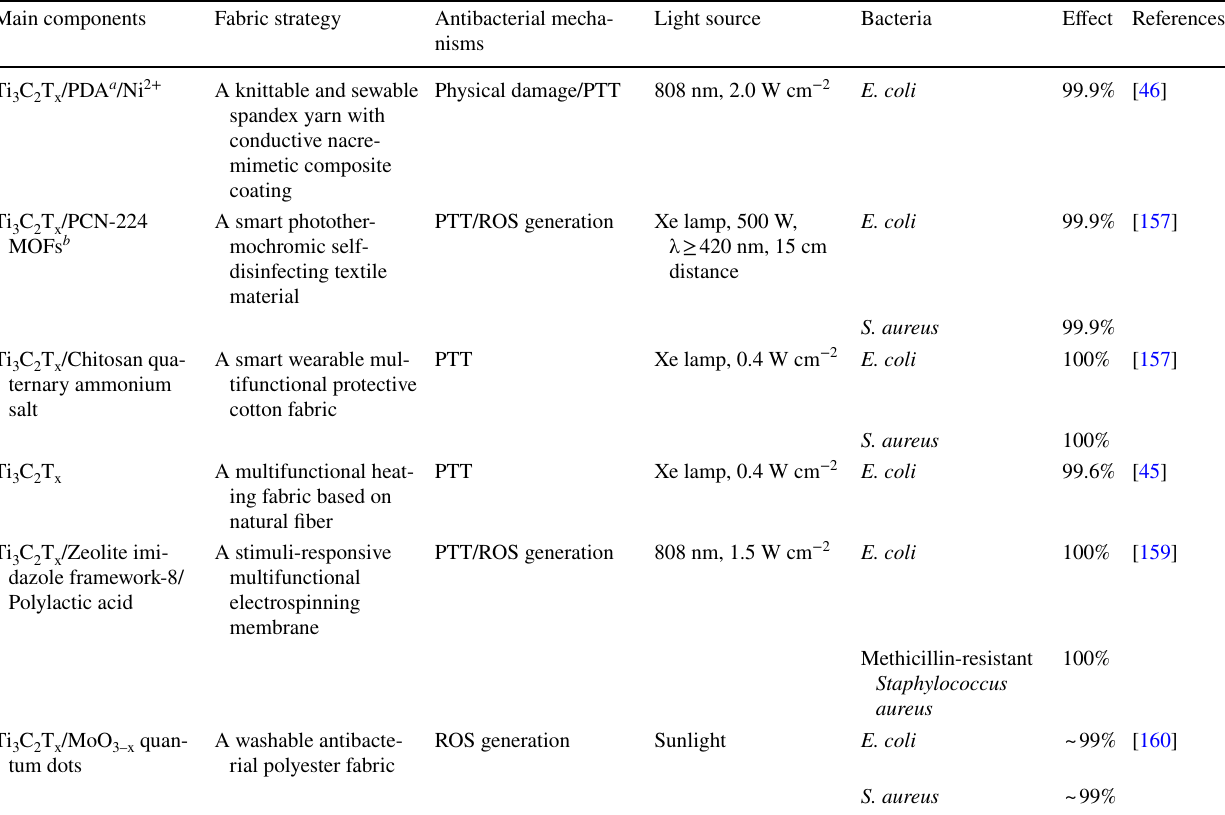
Table 6 Summary of photothermal-derived antibacterial applications using MXenes-containing fabrics